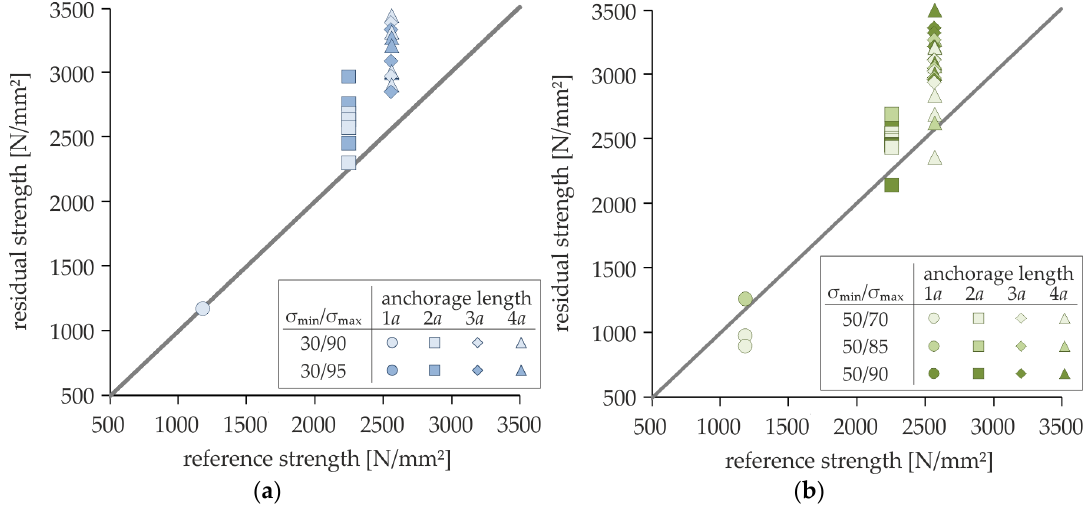
Figure 15. Comparison of residual and reference stresses: ( a ) 30% minimum stress; ( b ) 50% minimum stress.